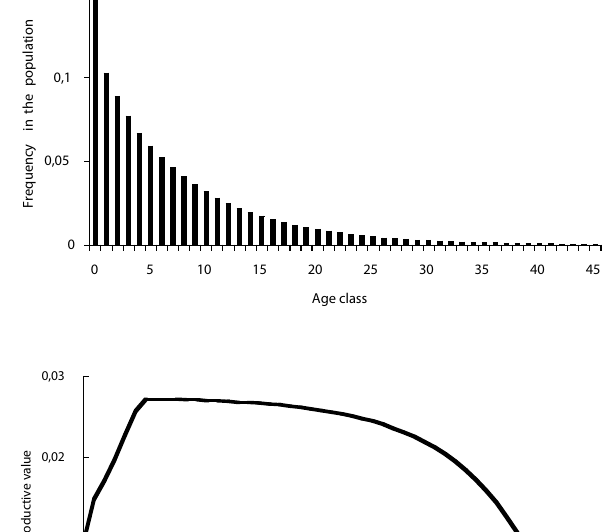
Fig. 7. Reproductive value of dif - ferent age classes of Baltic grey seals at λ= 1.075